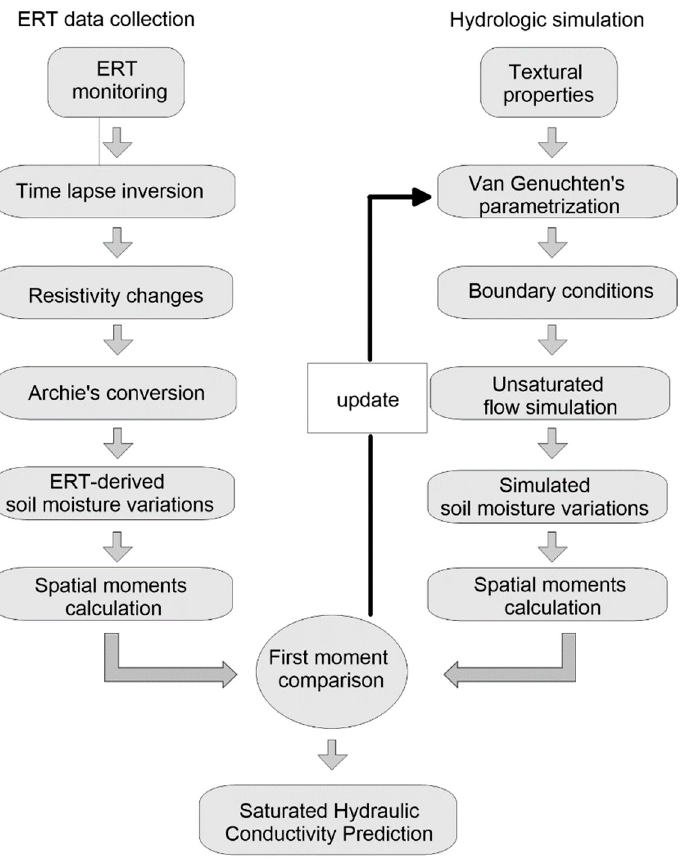
Figure 1. Workflow diagram describing the integrated hydrogeophysical approach used in the present case study for estimating saturated hydraulic conductivity, K s .